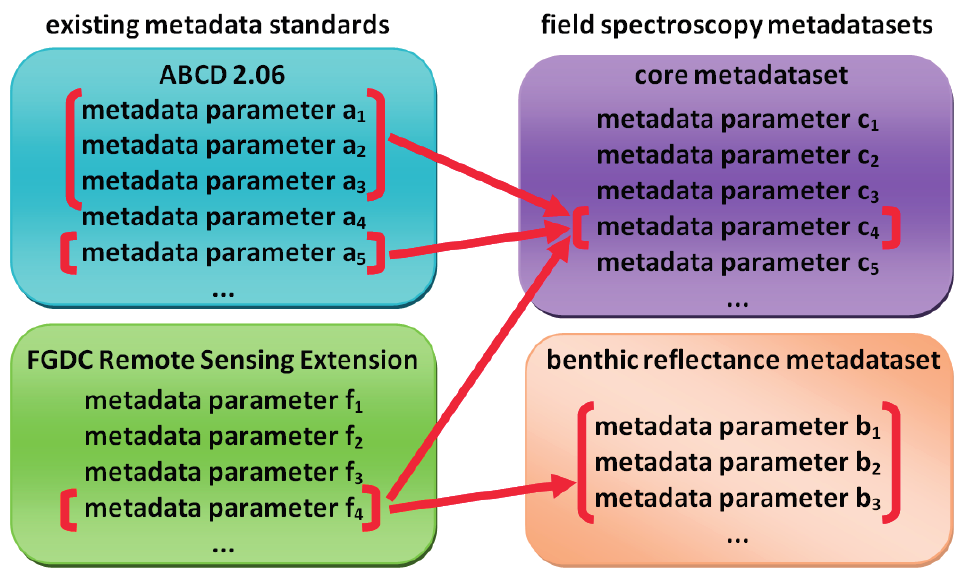
Figure 3. A conceptual example of a successful mapping from two existing geospatial metadata standards to the proposed field spectroscopy metadata